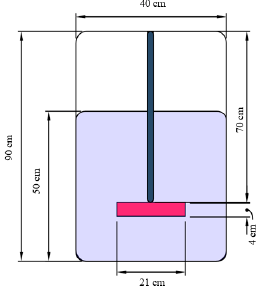
Figure 1. Bioethanol production process using Napier grass.